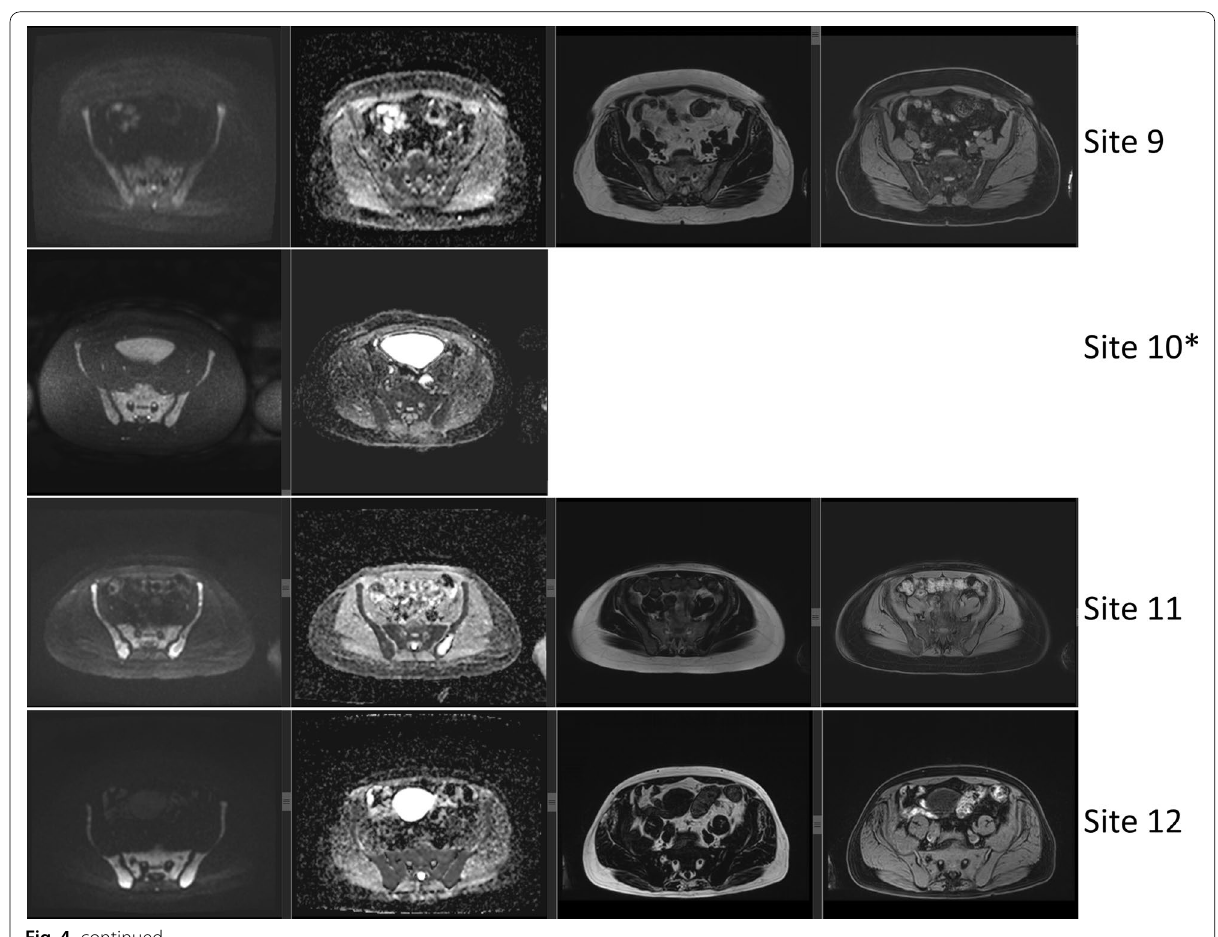
DWI data across the 12 subjects. A mean ADC value